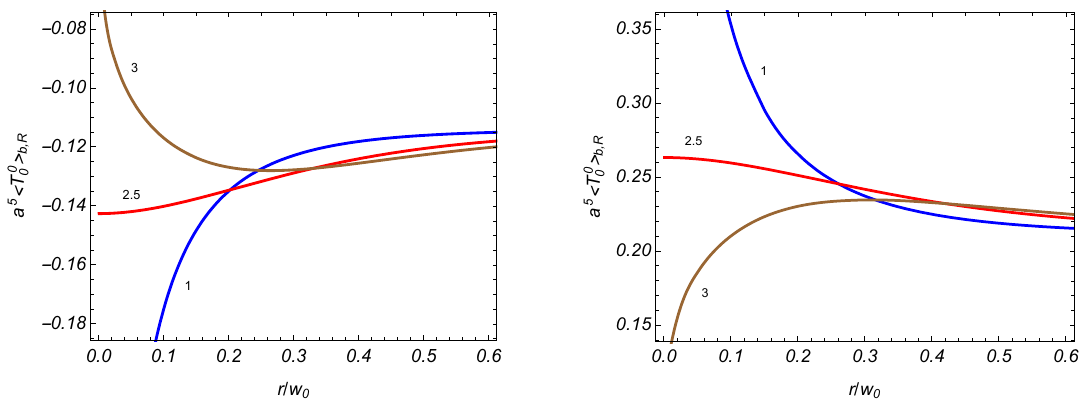
Figure 6 . Brane-induced contribution in the VEV of the energy density versus the distance from the cosmic string for s = +1 (left panel) and s = 1 (right panel) and for w/w 0 = 1 . 5. The numbers − near the curves are the values of the parameter q . The graphs are plotted for ma = 1 and α 0 = 0 . 3.